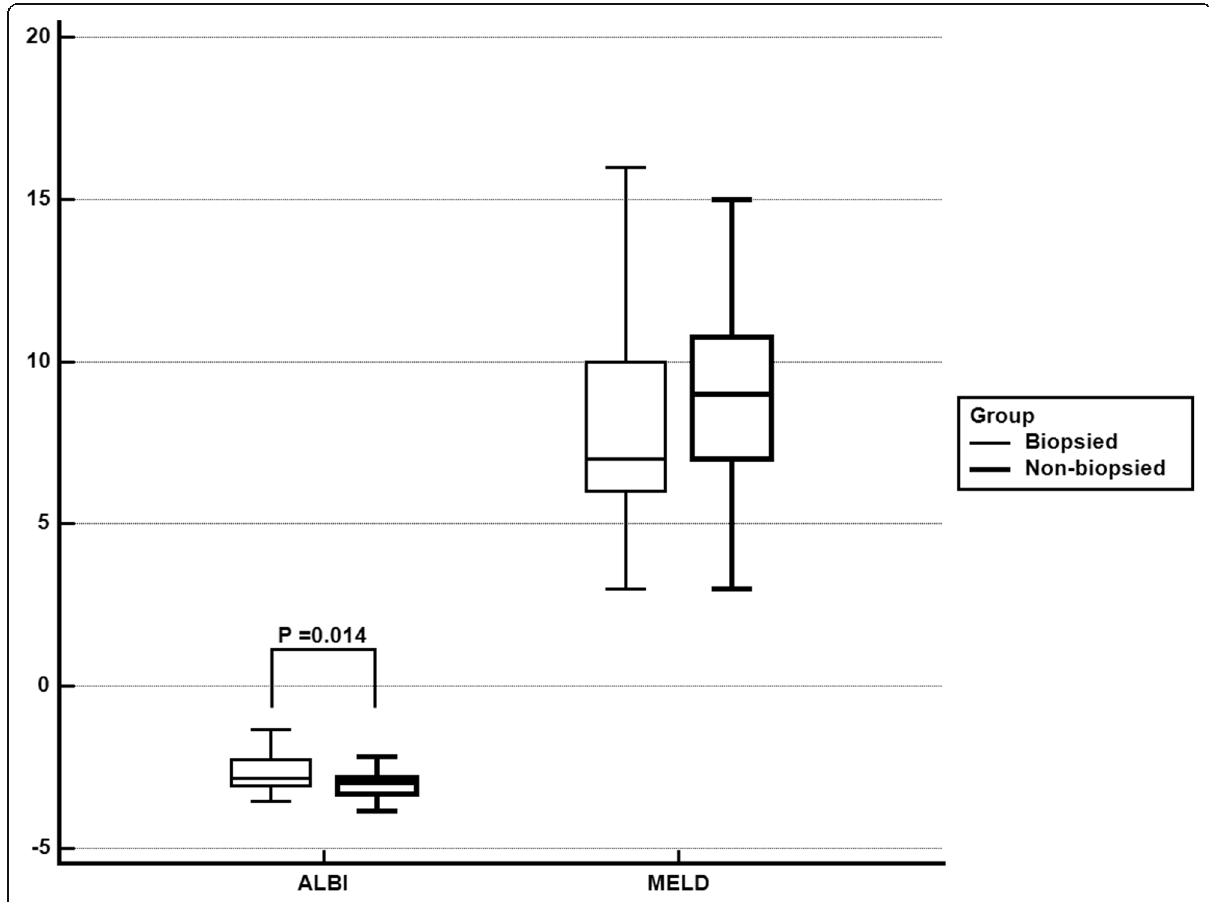
Fig. 2 Comparisons of the MELD and ALBI score in patients who did and did not undergo liver